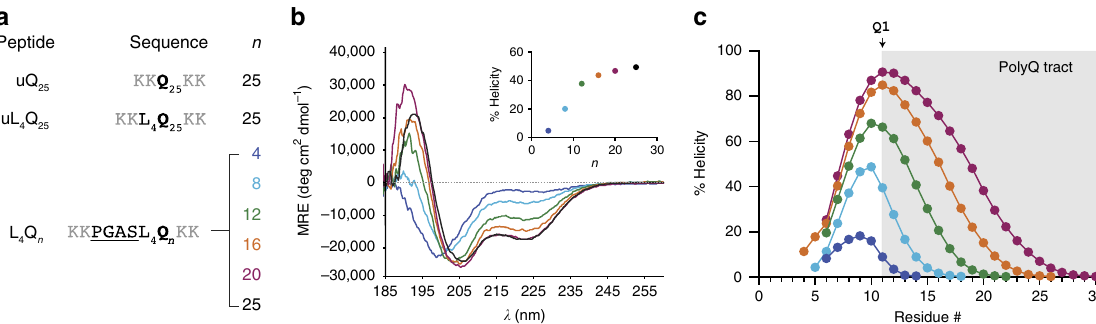
Fig. 1 The stability of the androgen receptor (AR) polyQ helix increases upon tract expansion. a Sequences of the uQ 25 , uL 4 Q 25 , and L 4 Q n peptides used in this work. b Circular dichroism (CD) spectra of peptides L 4 Q 4 to L 4 Q 25 measured at pH 7.4 and 277 K and plot of the helicity determined by CD as a function of the size of the polyQ tract length, n (inset, color coded). c Residue-speci fi c helicity of peptides L 4 Q 4 to L 4 Q 20 obtained from an analysis of the backbone chemical shifts measured by nuclear magnetic resonance (NMR) at pH 7.4 and 278 K by using the algorithm δ 2D 28 with an indication of the region of sequence corresponding to the polyQ tract and of its fi